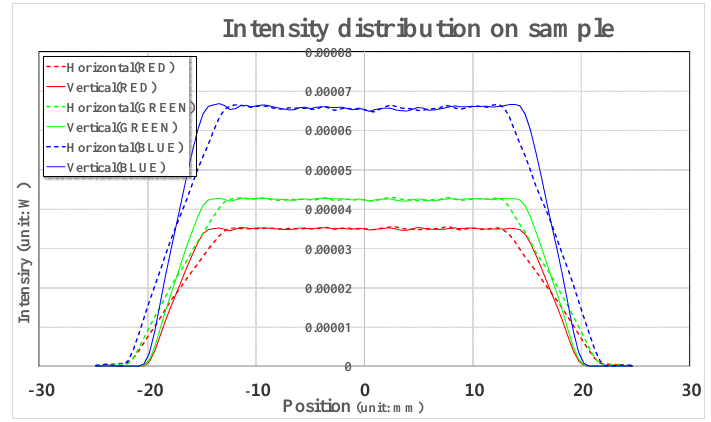
Figure 7. Light intensity distributions of the red, green, and blue LEDs with wavelengths of 628, 524, and 460 nm, respectively.